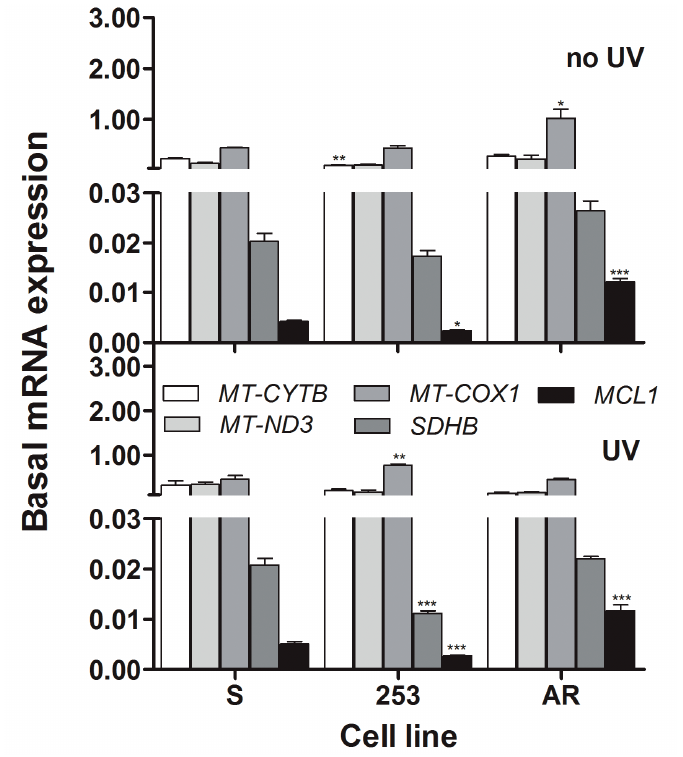
Figure 6. Basal mRNA expression of the nuclear SDHB (succinate dehydrogenase complex, subunit B), Mcl-1 (myeloid cell leukemia sequence 1) and mitochondrial COX1 (cytochrome c oxidase subunit I) gene in non-irradiated ( upper panel) or UV-irradiated ( lower panel) mouse 32D cells transfected with the BCR-ABL1 gene sensitive to imatinib (S) or cells displaying imatinib resistance caused by the Y253H mutation in BCR-ABL1 (253) or incubation of the sensitive cells with increasing doses of imatinib (AR). Cells were irradiated with UV light at 35 J/m 2 at room temperature at a dose rate of 0.12 J/(m 2 ·s) and the expression was determined by TaqMan probe-based real-time PCR (RT-PCR) assay and calculated by the 2 −Δ C t method and Δ C t was obtained by subtracting C t of ACTB mRNA from C t of mRNA of respective nuclear gene or C t of RNR2 from C t of COX1 . Data are shown as means ± SEM ( n = 3), * p < 0.005, ** p < 0.01, *** p < 0.001 as compared with imatinib-sensitive